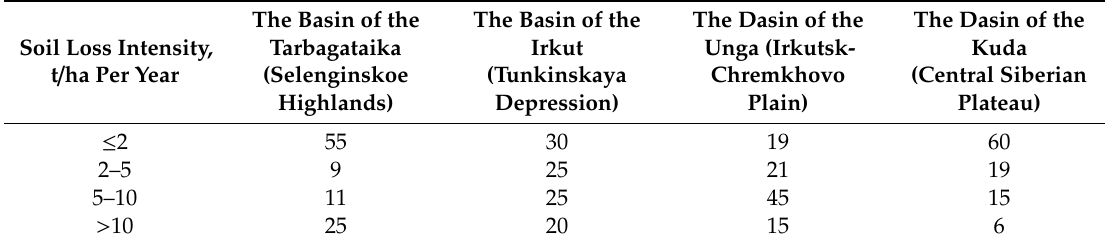
Table 2. Distribution of zones with di ff erent intensities of potential soil loss in river basins in the south of Eastern Siberia,